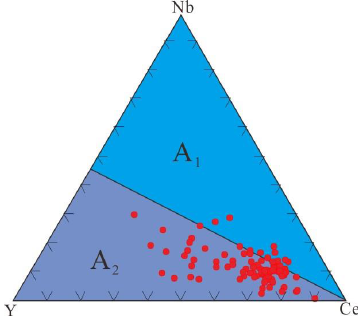
Figure 6. Plots of Nb-Y-Ce for the Devonian alkaline and mafic-ultramafic rocks in the northern NCC (areas of A 1 and A 2 modified after [70]; data from [19,20,38,41,44–46]). (areas of A 1 and A 2 modified after [70]; data from Subsequent to initial collision, several regimes are regarded as triggers for post-collision magmatism: (1) delamination of lithospheric mantle [71–73]; (2) convective thinning of the lithosphere [74] and (3) breakoff of subduting slab [75–78]. Both delamination and convective thinning models would cause some recognizable effects, such as rapid uplift of overriding plate,